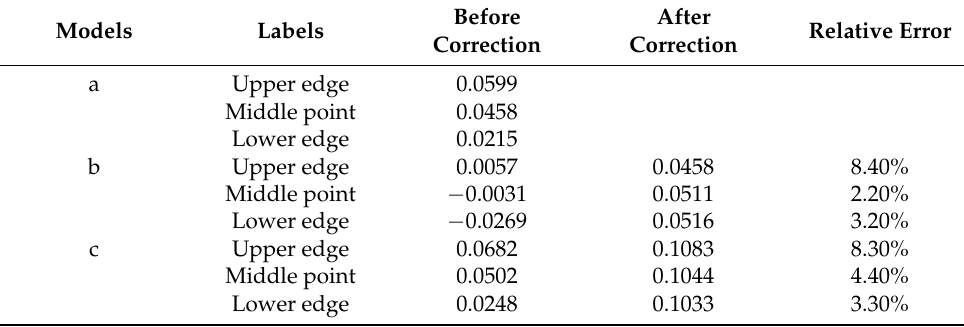
Table 2. Inversion results of radius of homogeneous medium